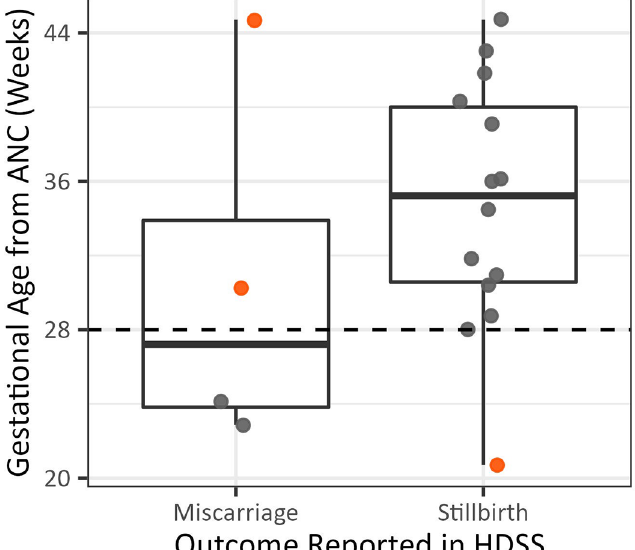
Gestational age at the date of the pregnancy outcome was calculated from the latest recorded value in the ANC data. ANC- estimated gestational age has been plotted separately for pregnancies reported as miscarriages and stillbirths in the HDSS. The horizontal dashed line indicates the 28 week gestational age threshold used to distinguish between miscarriage and stillbirth.